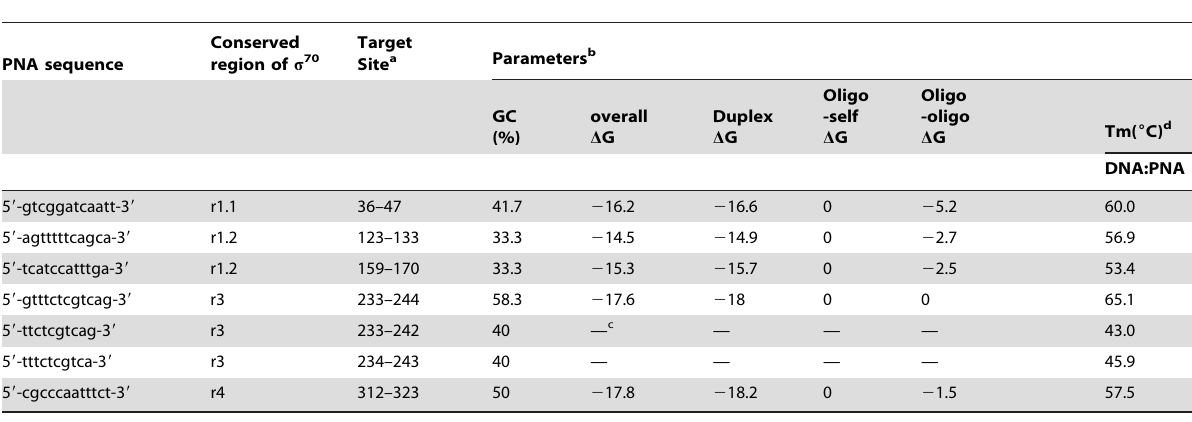
Table 2. Binding parameters predicted by software Oligo walk 5.0 and